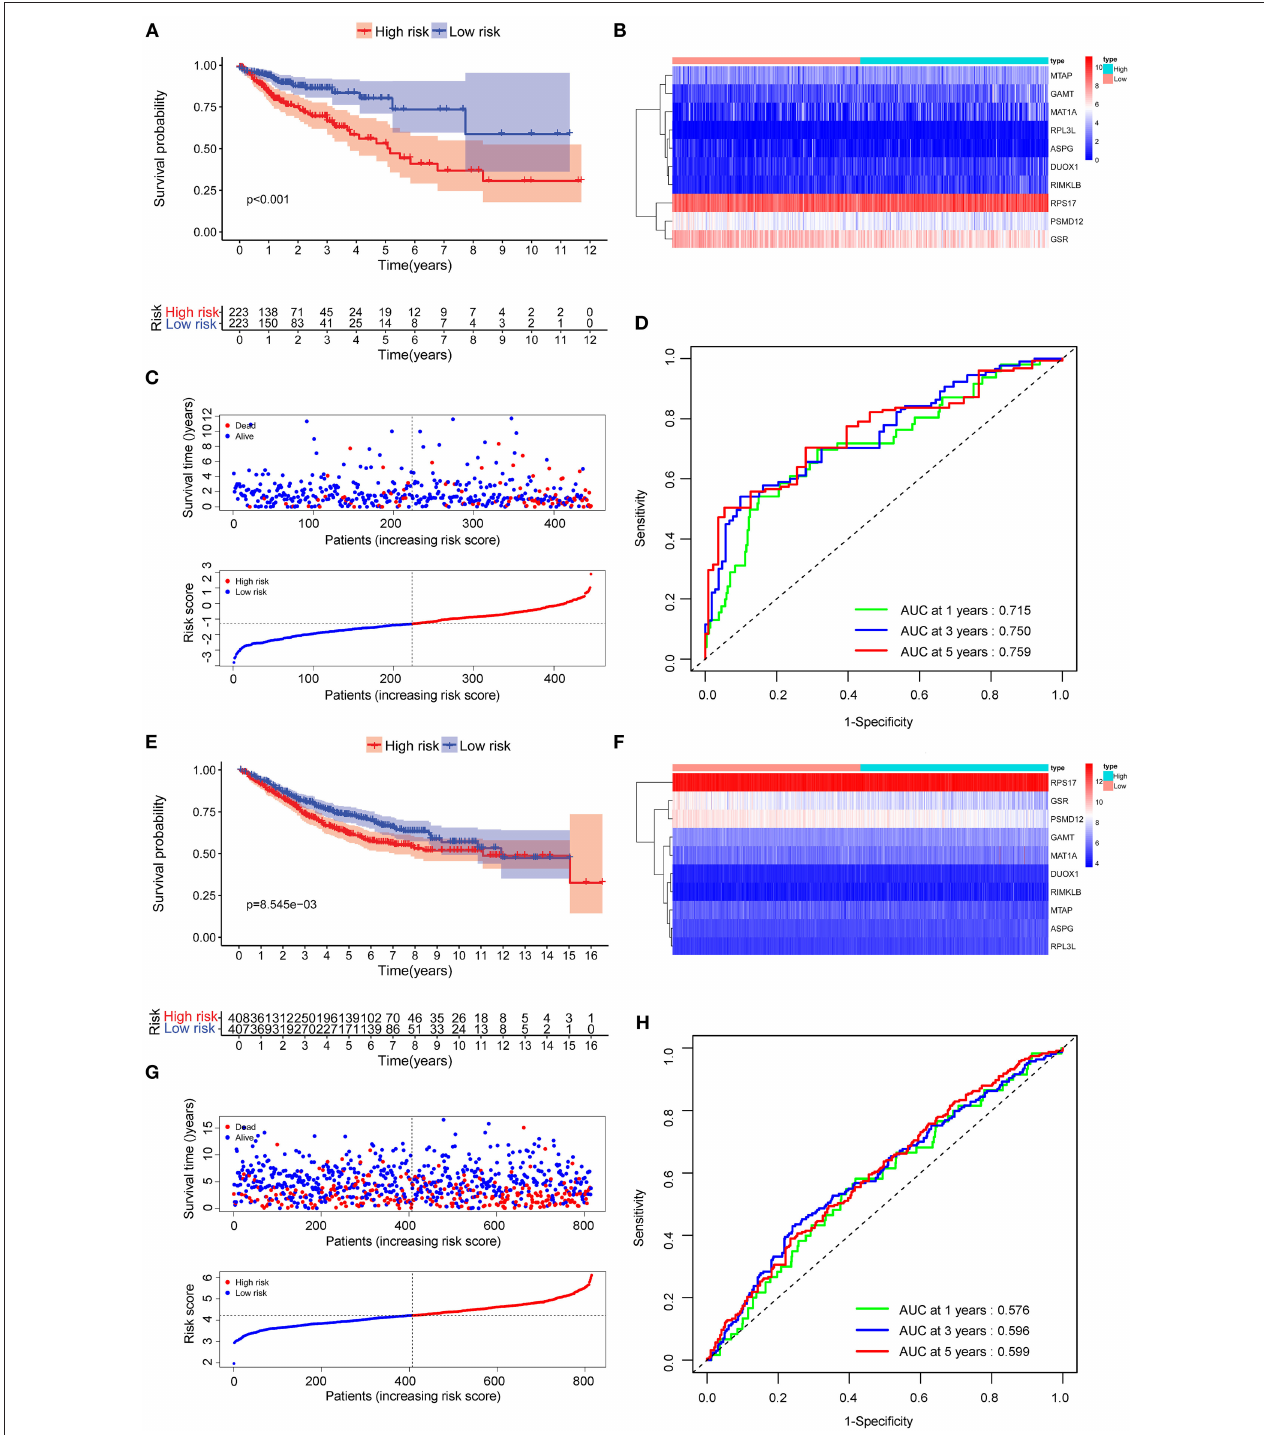
FIGURE 3 | Evaluation of the prognostic performance of the AAMRGs signature in the TCGA dataset and GEO dataset. (A) The Kaplan-Meier survival curves of the AAMRGs signature in TCGA dataset. Patients from the TCGA dataset were stratified into two groups according to the median risk scores. (B,C) The distribution of risk score, survival outcomes, and the expression pattern of 10 AAMRGs in the TCGA dataset. (D) The ROC curves for predicting the 1-, 3-, and 5-year OS in the TCGA dataset. (E) The Kaplan-Meier survival curves of the AAMRGs signature in GEO dataset. Patients from the GEO dataset were stratified into two groups according to the median risk score. (F,G) The distribution of risk score, survival outcomes, and the expression pattern of nine AAMRGs in the GEO dataset. (H) The ROC curves for predicting the 1-, 3-, and 5-year OS in the GEO dataset.